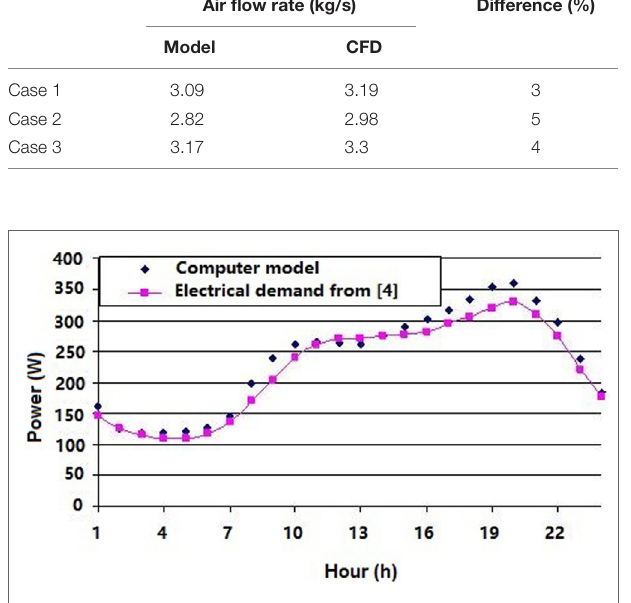
FigUre 5 | comparison of the hourly household appliances electricity demand .